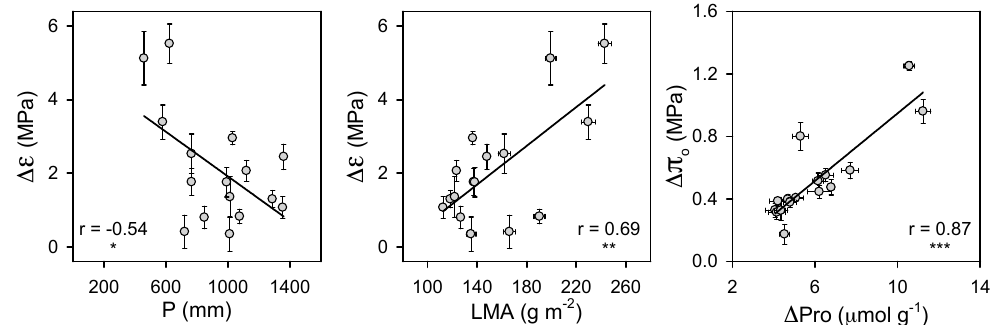
Figure 7. Relationships derived from the principal component analysis between diverse parameters for the 16 Quercus suber populations (* p < 0.05; ** p < 0.01; *** p < 0.001). Each point is the mean (± SE) value for one population. LMA, leaf mas per area; P, annual precipitation; Δ , change in a determinate variable between control and water stressed seedlings; Δ Pro, change in proline concentration; Δε , change in bulk modulus of elasticity; Δπ o , change in osmotic potential at full turgor.